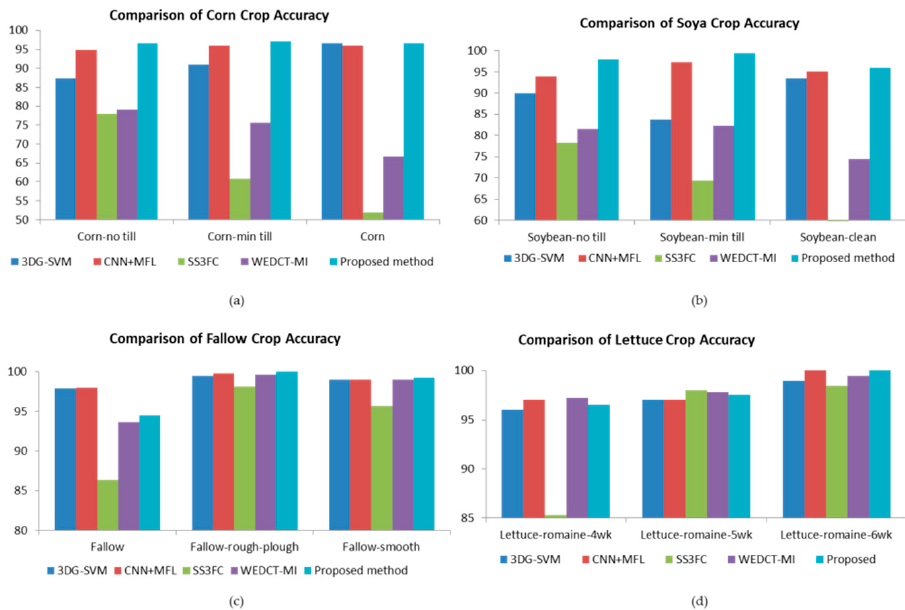
Figure 10. Comparison of crop classification accuracy Indian Pines: ( a ) Corn ( b ) Soya Salinas: ( c ) Fallow ( d ) Lettuce.